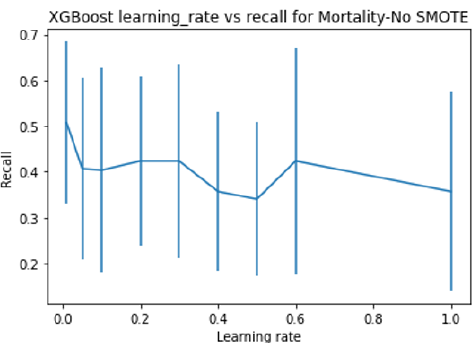
Figure 3. Shows the recall versus learning rate for all three outcomes without data augmentation on the training set, plotted using XGboost as the base model. Without data augmentation, the event prediction capability of the models are 10–35%, 50–57%, and 35–50% for sepsis, MDRO, and mortality, respectively.